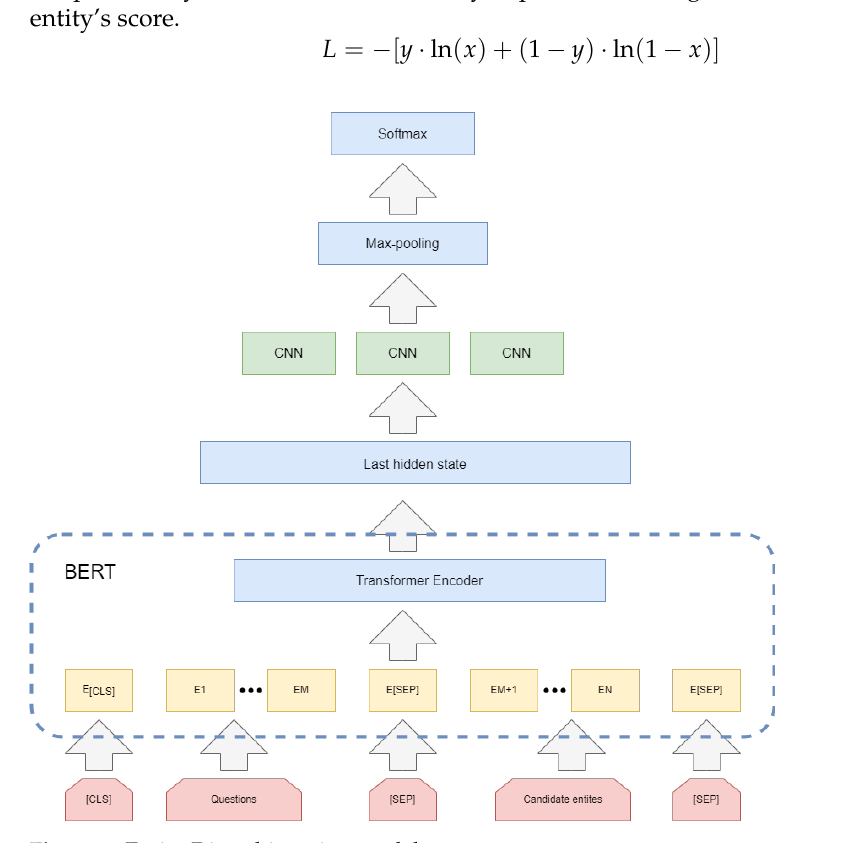
Figure 8. Entity Disambiguation